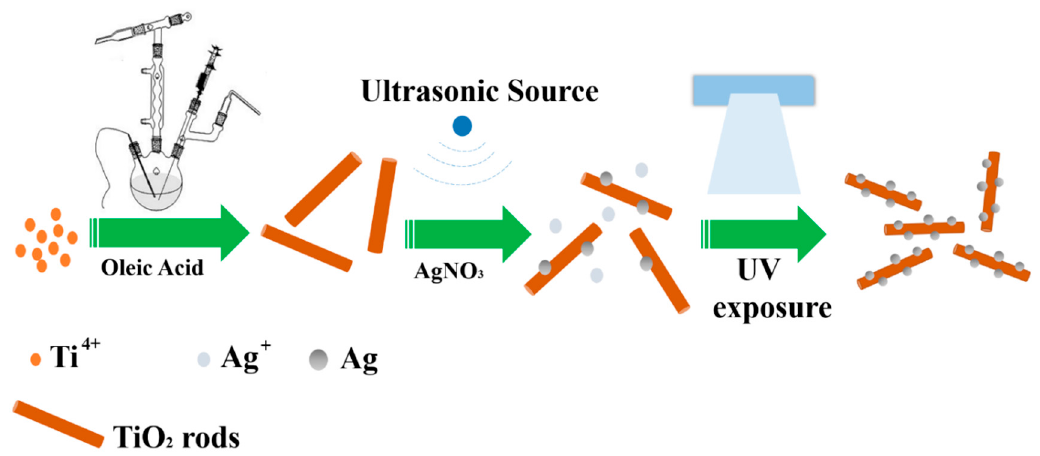
Figure 1. Scheme of the fabrication of Ag-TiO 2 nanorod composites.